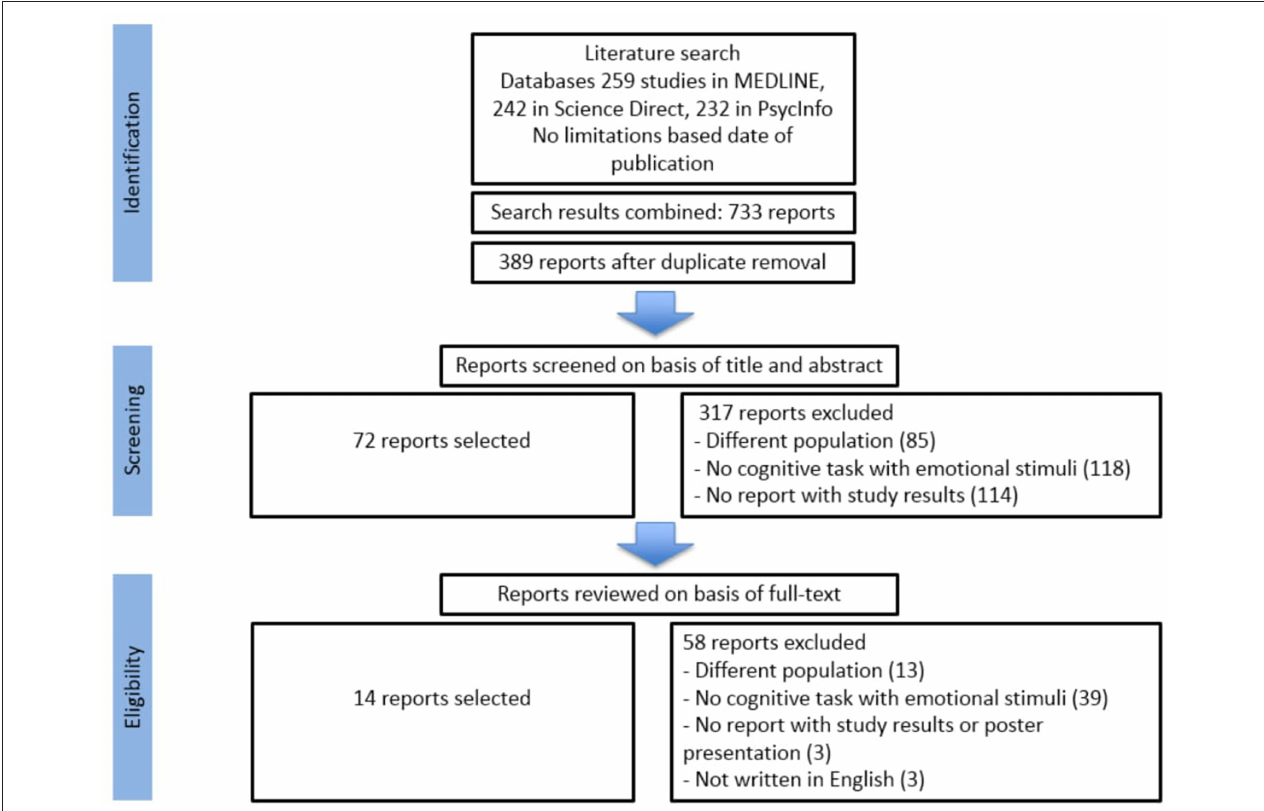
FIGURE 1 | Summary of literature search, adapted from PRISMA (Moher et al., 2009).